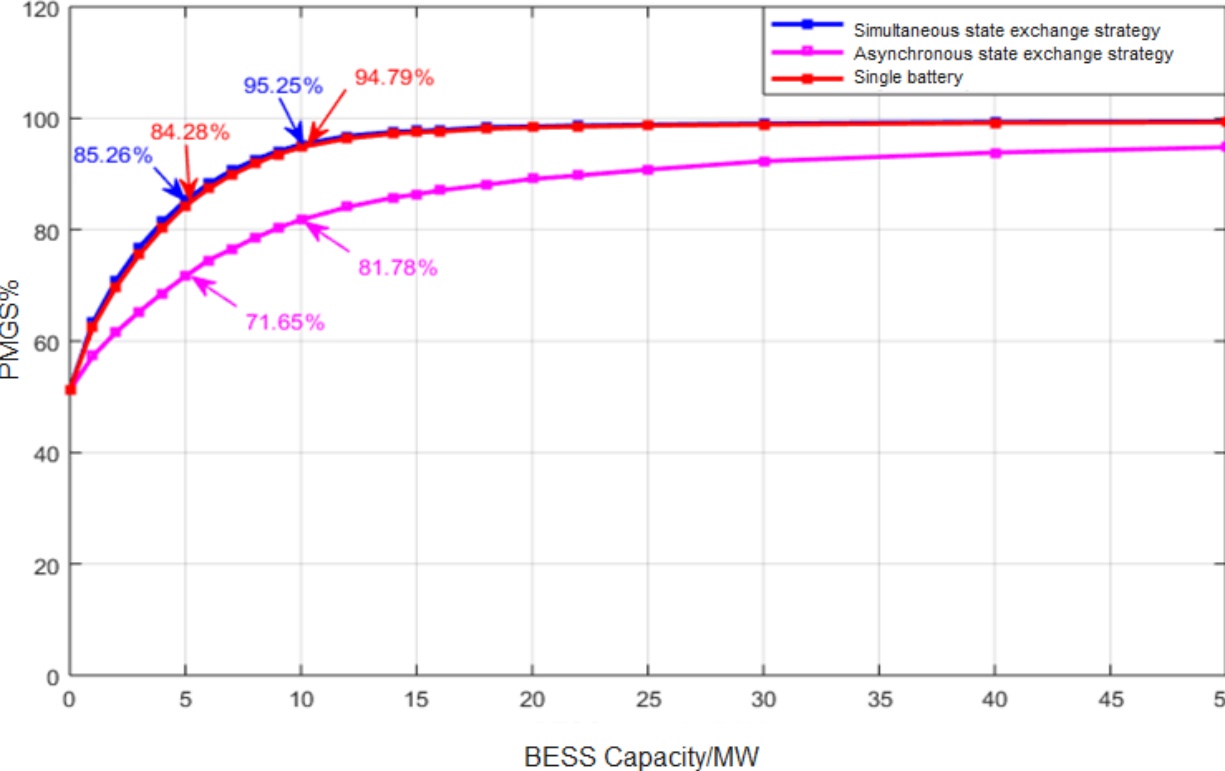
Figure 8. Probabilities of meeting generation schedule with various BESS capacities.